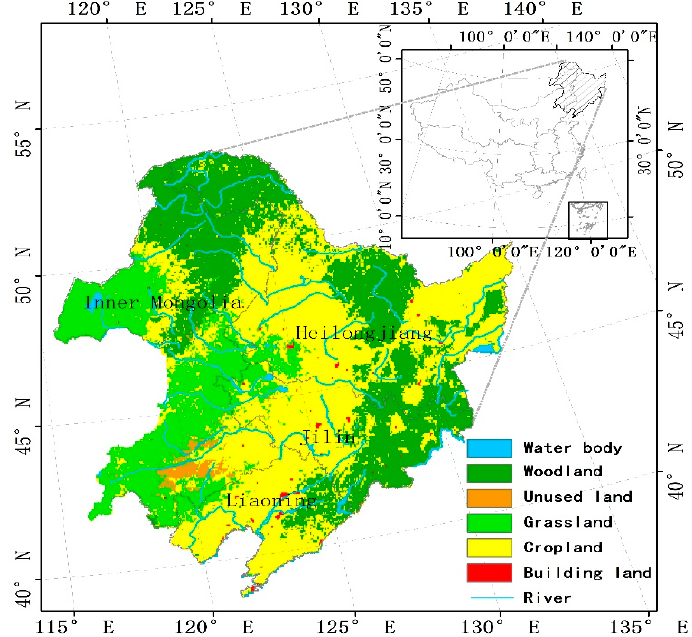
Figure 1. Map of the land cover type and the distribution of river in Northeast China.